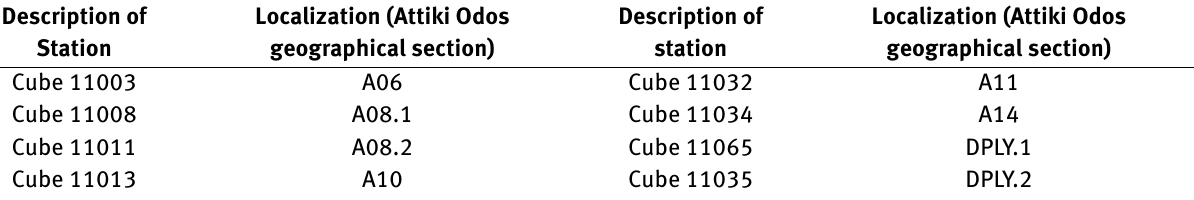
Table 2: Noise monitoring system of Attica Tollway